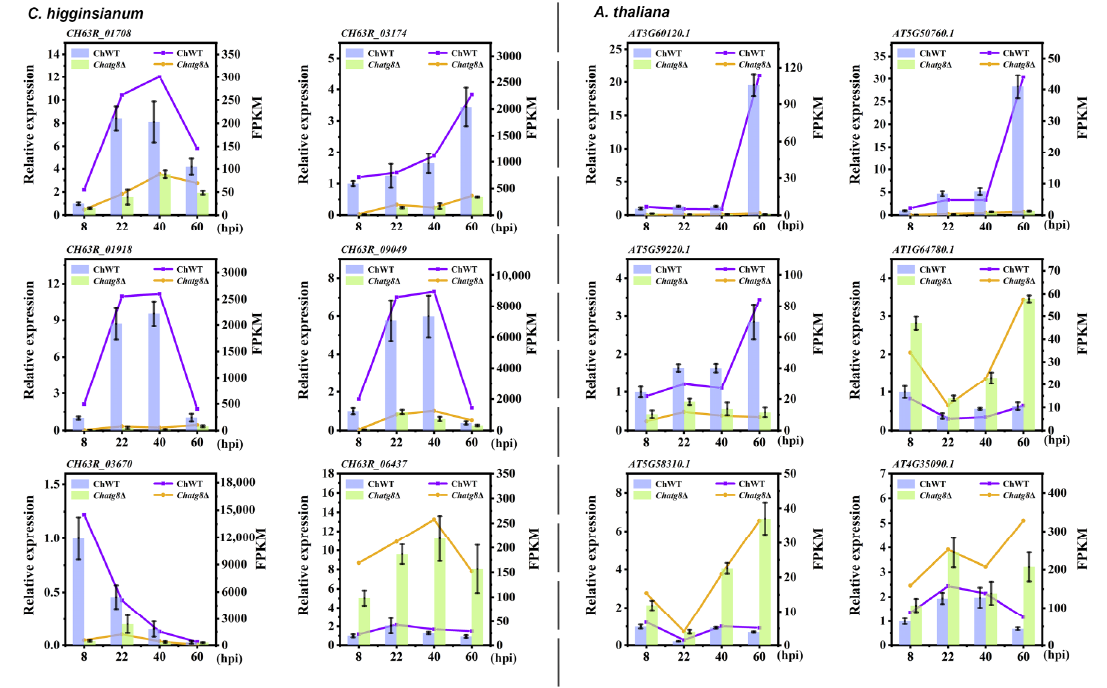
Figure 8. Confirmation of RNA-seq via RT-qPCR analysis. The expression of twelve selected DEGs from the RNA-seq analysis were measured by RT-qPCR in ChWT-8 hpi, Chatg8 Δ-8 hpi, ChWT-22 hpi, Chatg8 Δ-22 hpi, ChWT-40 hpi, Chatg8 Δ-40 hpi, ChWT-60 hpi, and Chatg8 Δ-60 hpi. The histograms were plotted using data obtained by RT-qPCR and the corresponded line chart was plotted by FPKM values from the RNA-seq analysis, with different colors indicating different samples. Each bar represents the mean value with standard errors of three independent experiments.